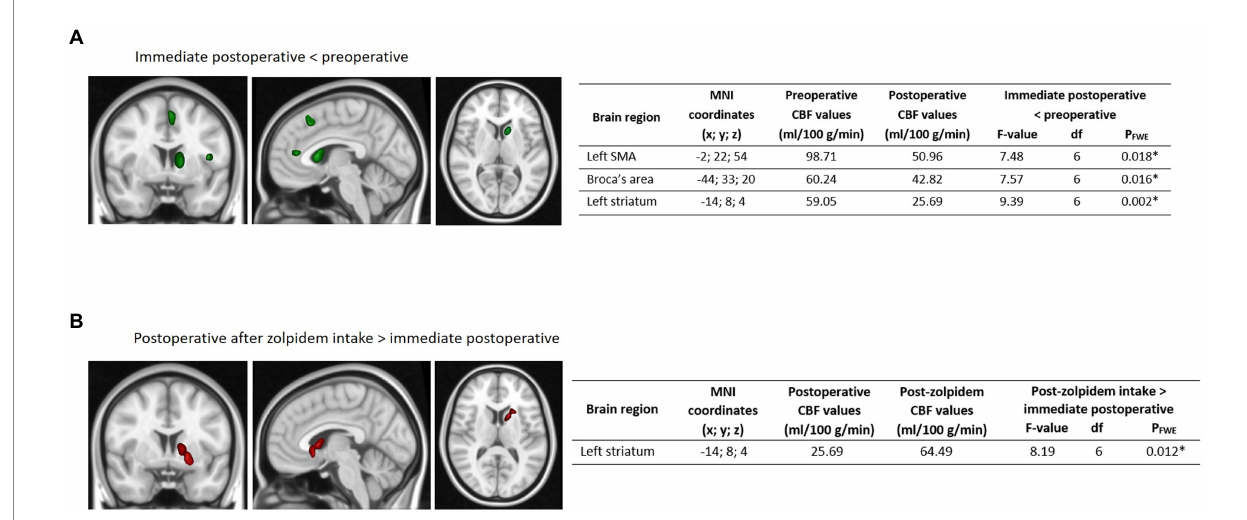
FIGURE 1 Comparison of whole brain rest CBF at the different time-points. Whole brain results showing (A) significantly decreased ASL-CBF values localized in the left SMA, Broca’s area, and left striatum (in green) in the immediate postoperative images relative to the preoperative images and (B) significantly increased ASL-CBF values localized in the left striatum (in red) in the post-zolpidem intake images relative to the immediate postoperative images. Maximum intensity projections of significant T statistic clusters were superimposed on a 2D rendering of T1-weighted images in MNI space. The characteristics of significant clusters, with the mean CBF values, are summarized in the respective tables, with results presented using a family-wise error (FWE) correction. MNI refers to the MNI coordinates. R: right, L: left, CBF: cerebral blood flow, SMA: supplementary motor area, ASL: arterial spin